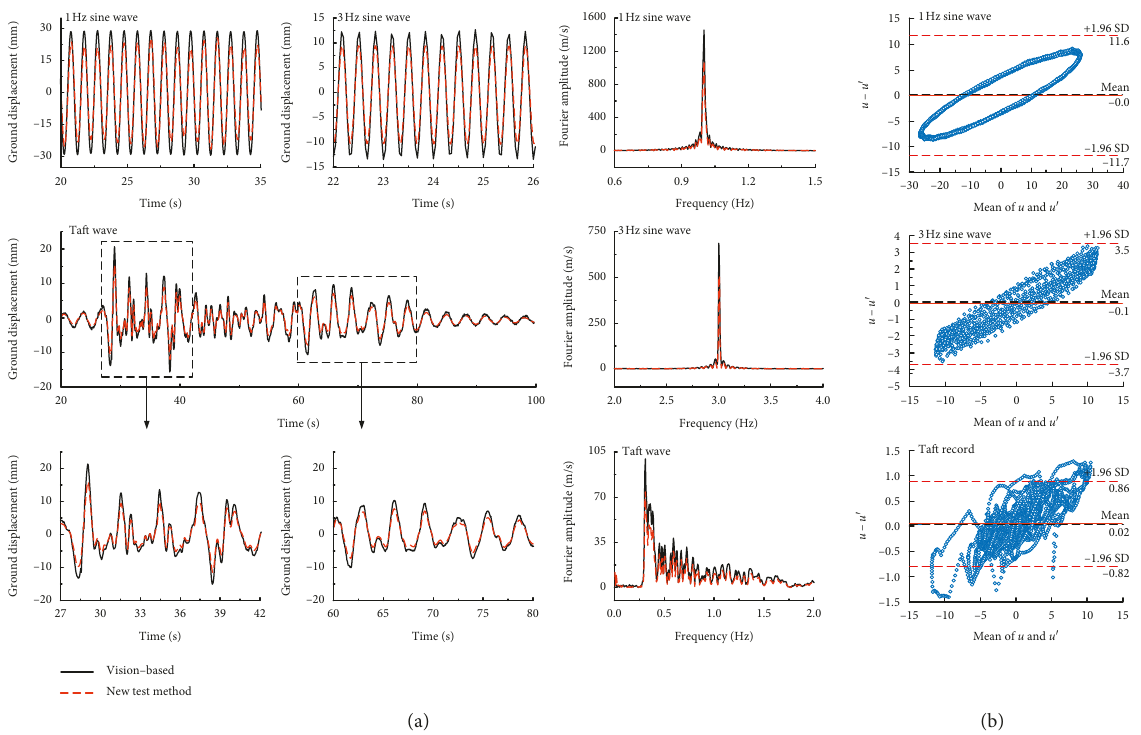
Figure 11: Comparison of ground displacements between experimental data and new method. (a) Comparison between time domain and frequency domain. (b) Bland–Altman diagram.